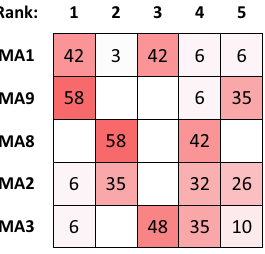
Figure 3. Ranking Strength over all normalization/aggregation combinations (5 alternatives).